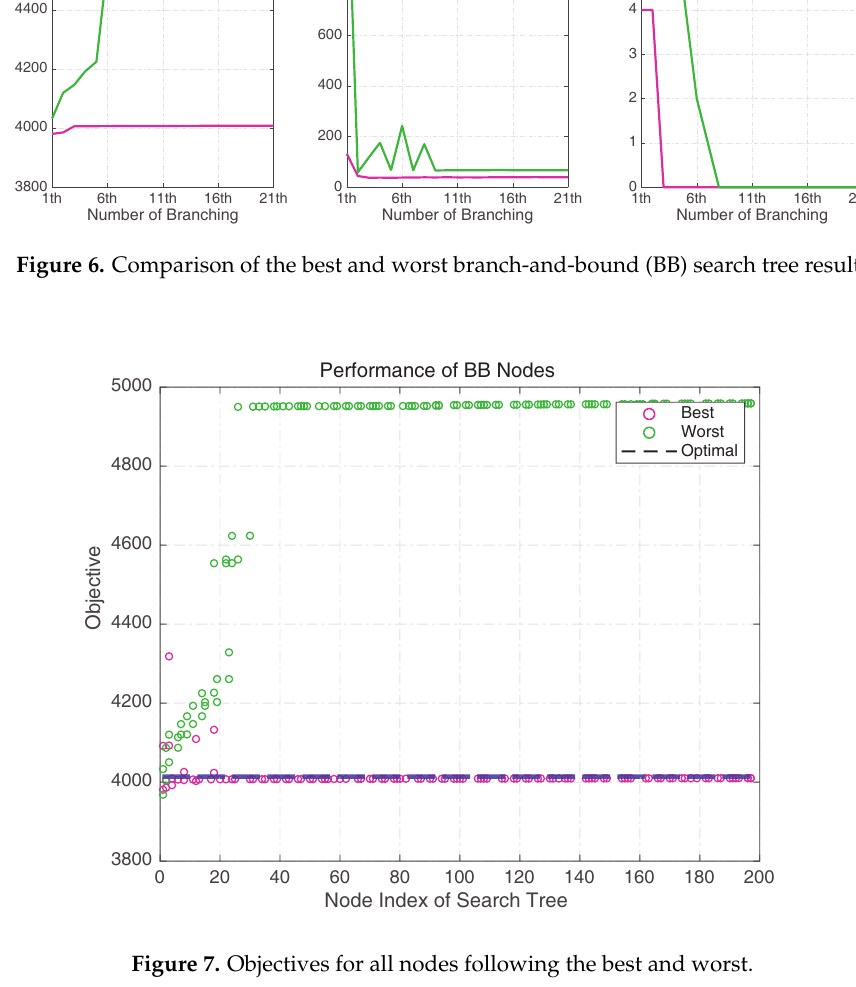
Figure 7. Objectives for all nodes following the best and